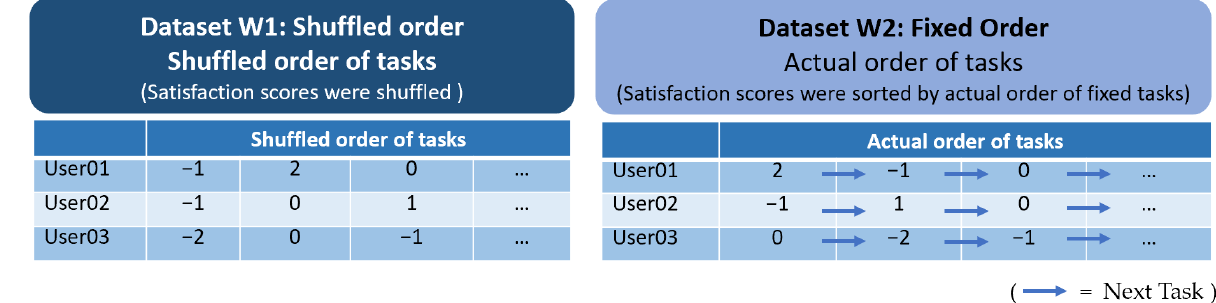
10 of 18 Figure 7. Evaluating user satisfaction while using a travel agency website.